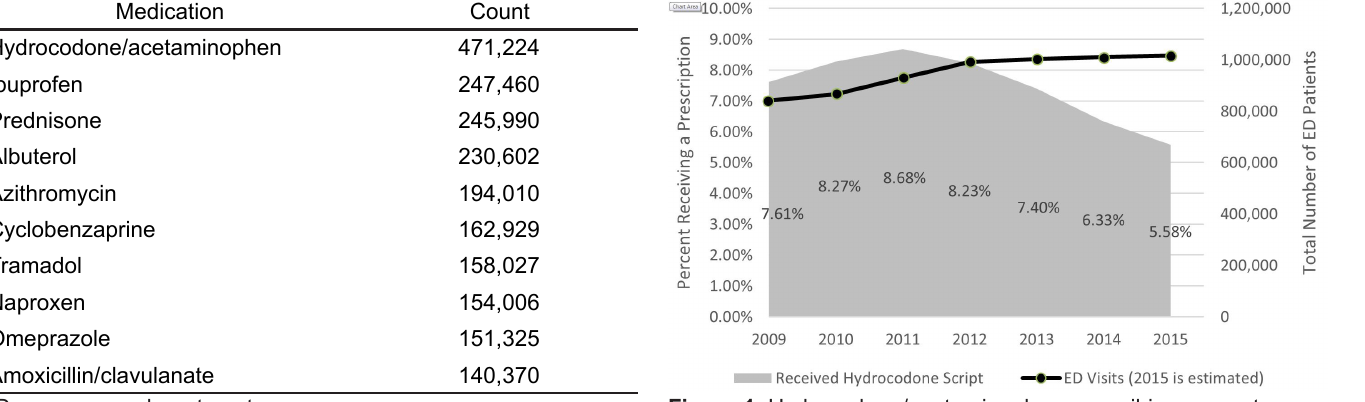
Figure 1. Hydrocodone/acetaminophen prescribing percentages. ED, emergency department